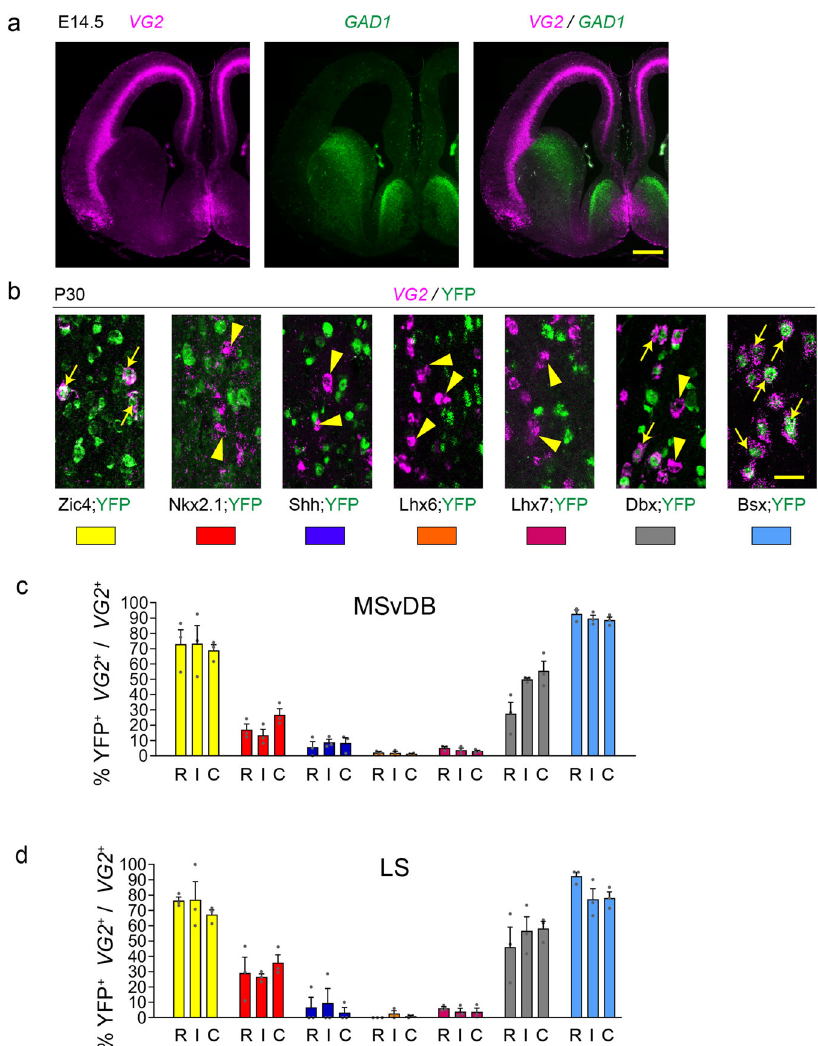
Fig. 5 Septal origins of septal glutamatergic neurons with unique developmental codes. a VG2 and GAD1 expression in the forebrain of a WT E14.5 mouse. b Contribution of different forebrain domains to VG2 MS populations. Double-labelling for VG2 and YFP in the various transgenic lines at P30. White arrows and arrowheads indicate double and single labelled cells, respectively. c , d Histograms showing the percentage of VG2 neurons double labelled for YFP over the total VG2 population in the MSvDB ( c ) and LS ( d ). Each transgenic line in c , d is identi fi ed by a different colour as shown in b and as summarised in Fig. 2d, e. n = 3 brains per transgenic line per marker. Histograms show mean + SEM. Source data are provided in Supplementary Data 1. Scale bars: a 200 μ m; b 25